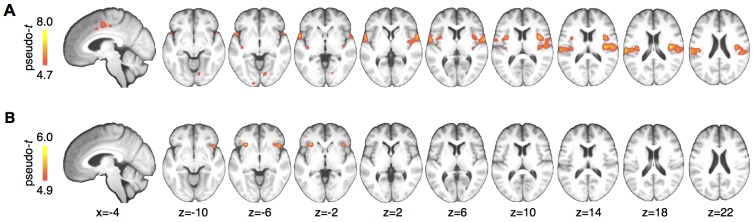
Whole brain results.(A) A main effect of stimulus was observed in pain processing regions including insula, parietal operculum, and midcingulate cortex. (B) Anterior insula showed a significant interaction between cue and stimulus. Maps are displayed at p<0.05, whole brain FWE corrected using nonparametric permutation testing resulting in pseudo-t maps.